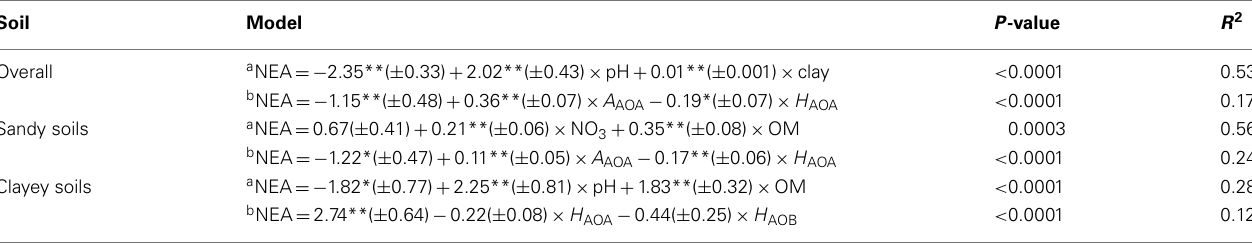
Table 3 | Best regression models for NEA in the eight soils over five sampling times.